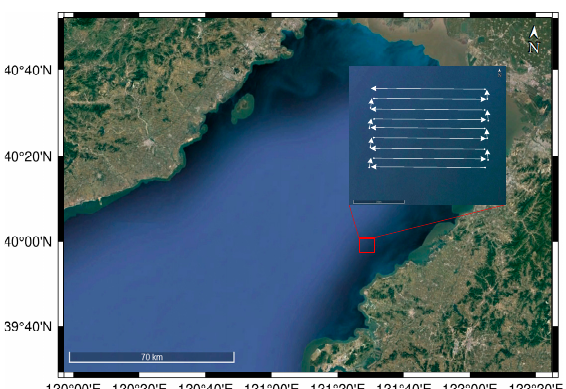
Figure 14. The location of the experiment and the sailing routes of SSS measurement.